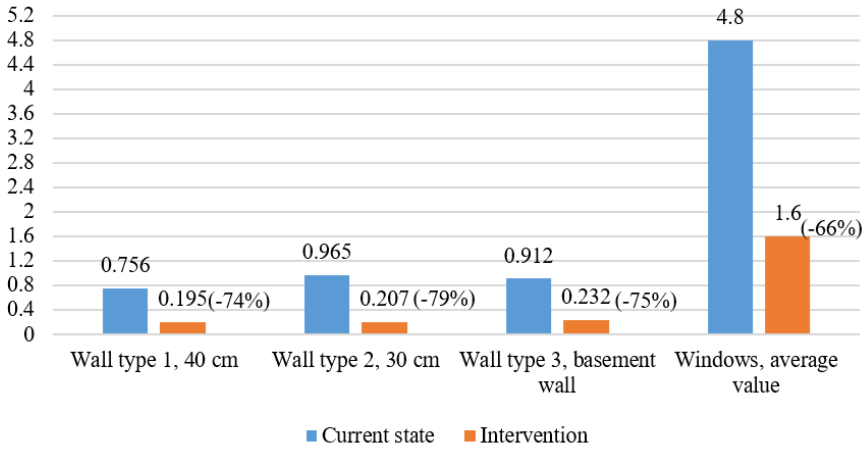
Figure 8. Stationary thermal transmittance (W/m 2 K) values for the existing building and the insulated one.